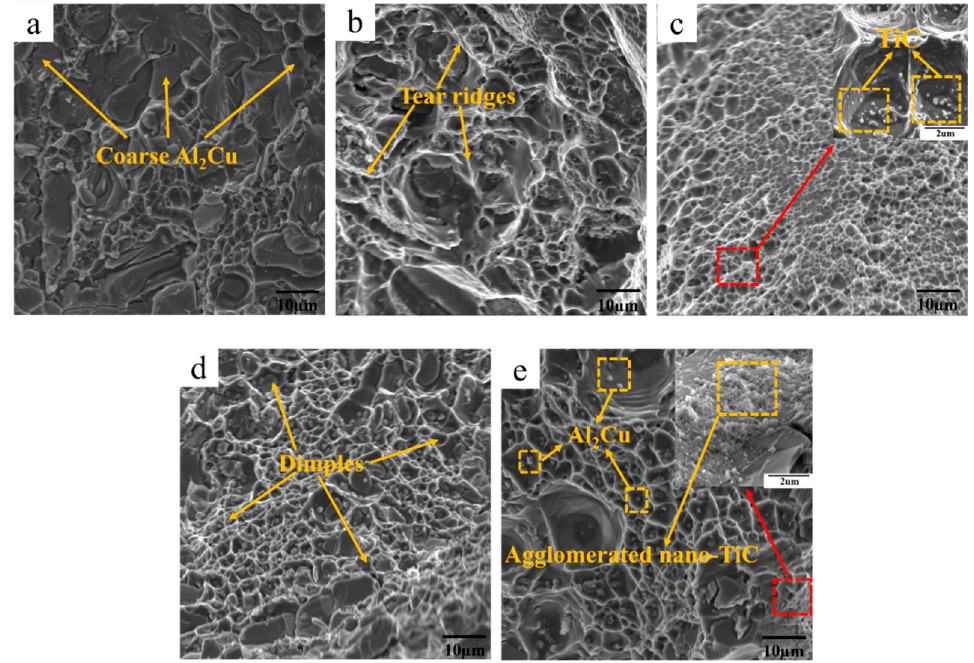
Figure 10. Fracture surfaces of the forged and heat-treated TiC/2219 nanocomposite with different nanoparticle contents: ( a ) 0 wt.%, ( b ) 0.5 wt.%, ( c ) 0.9 wt.%, ( d ) 1.3 wt.%, and ( e ) 1.7 wt.%, respectively.